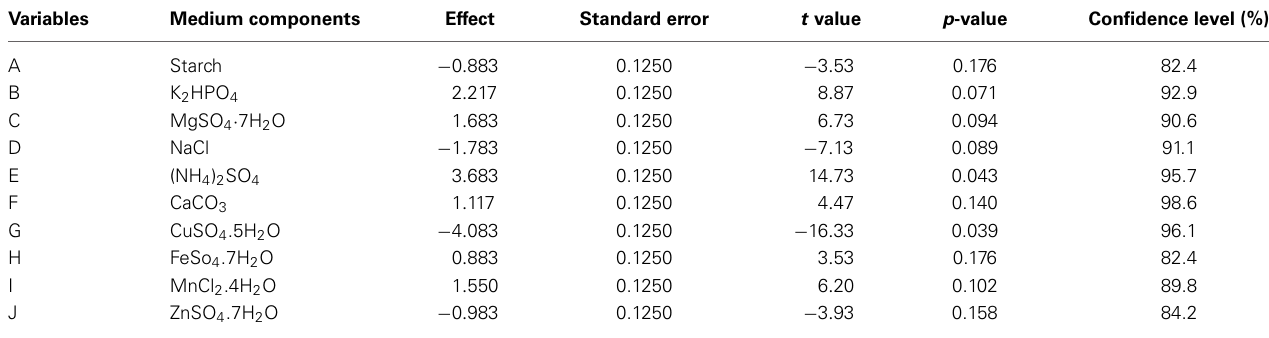
Table 7 | Statistical analysis of effects of variables (media components) on antibacterial activity as per PBD.